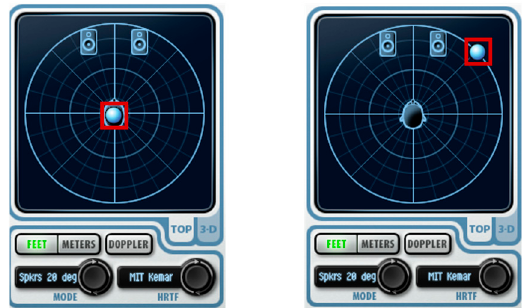
Figure 4. Software configuration interface: non-directional sound ( left ); directional sound ( right ). Note that we can change the sound direction by moving the sound source location (within the red rectangle border).